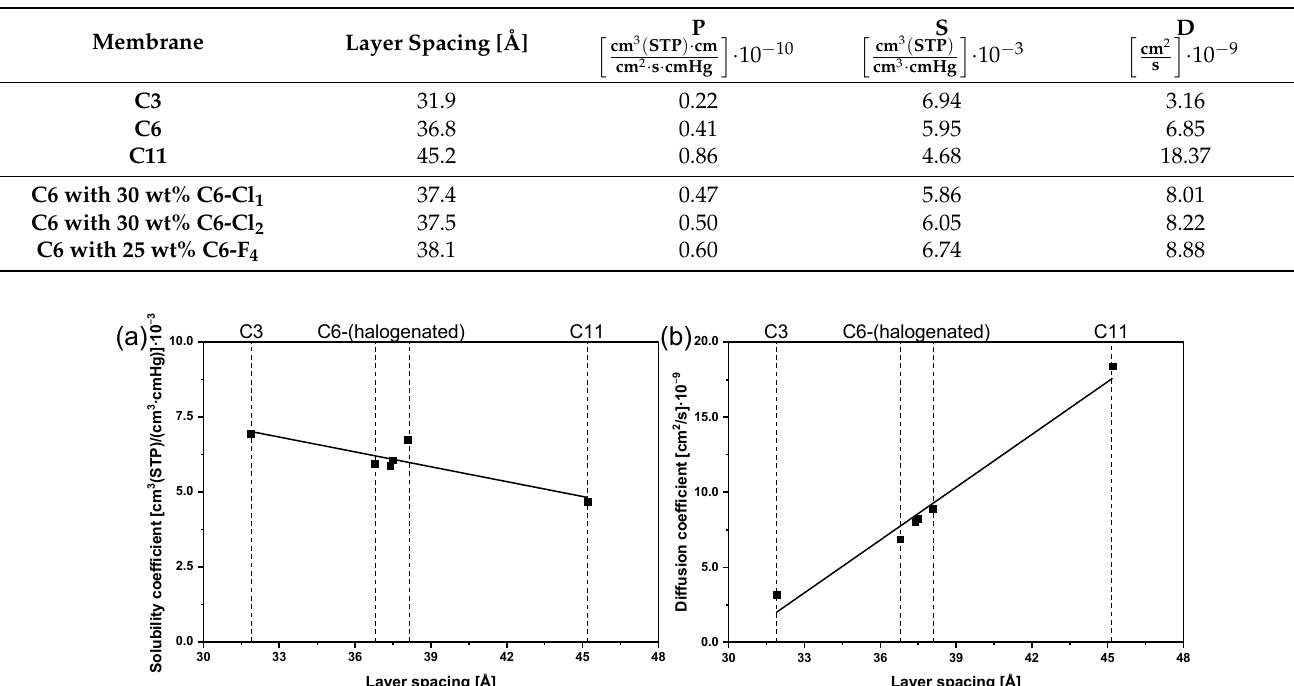
Table 4. The layer spacing, CO 2 permeabilities, CO 2 solubility coefficients measured at 40 ◦ C and 6 bar and the associated calculated diffusion coefficients of all membranes.